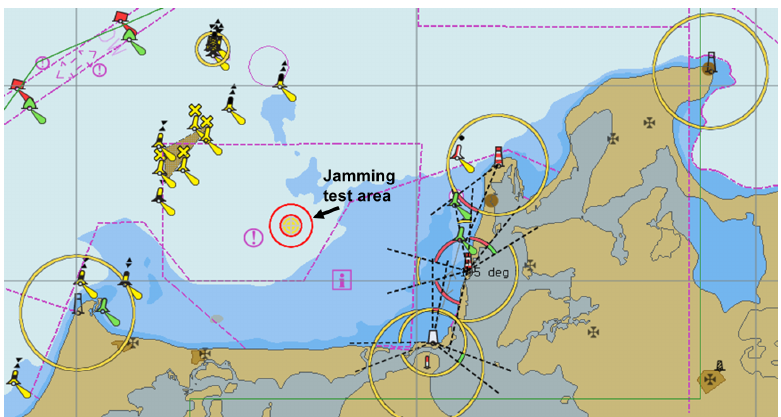
Figure 1. An overview of the civilian maritime jamming test area 10 km north of Peninsula Darß (54,5474 N, 12,8154 E).